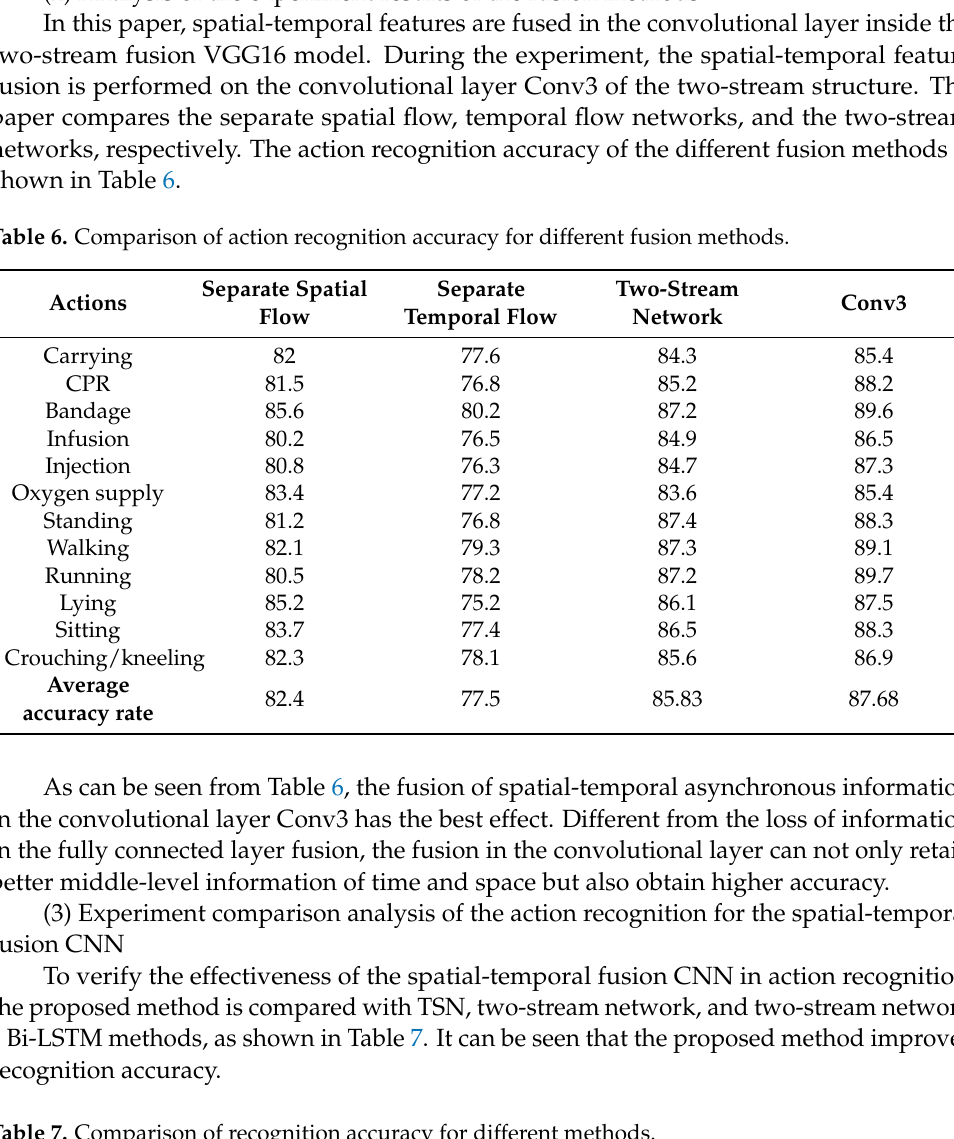
Table 7. Comparison of recognition accuracy for different